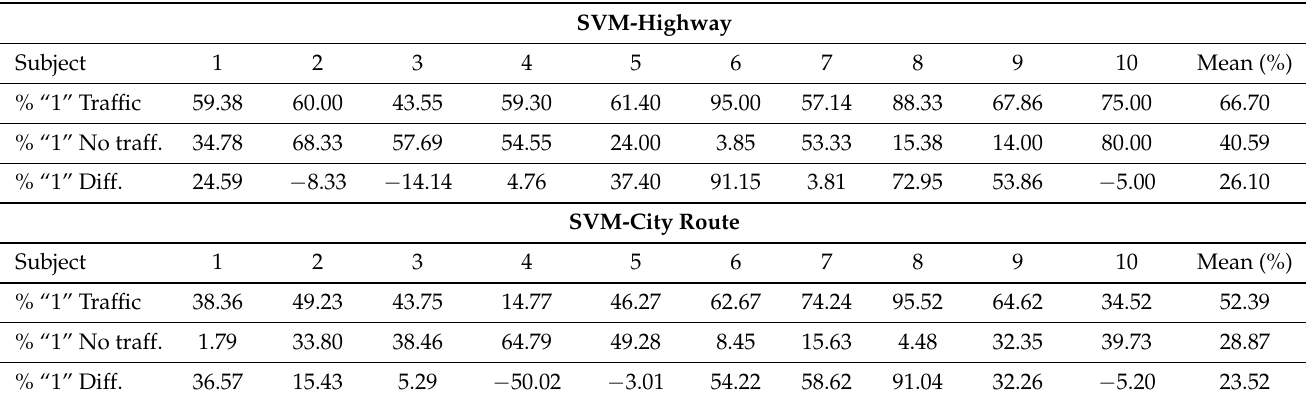
Table 4. Total number of intervals identified as “stress” (in %), considering the SVM classifier for each subject and each road segment (in the two driving situations). The numeric difference between them (with traffic–no traffic) is also displayed.